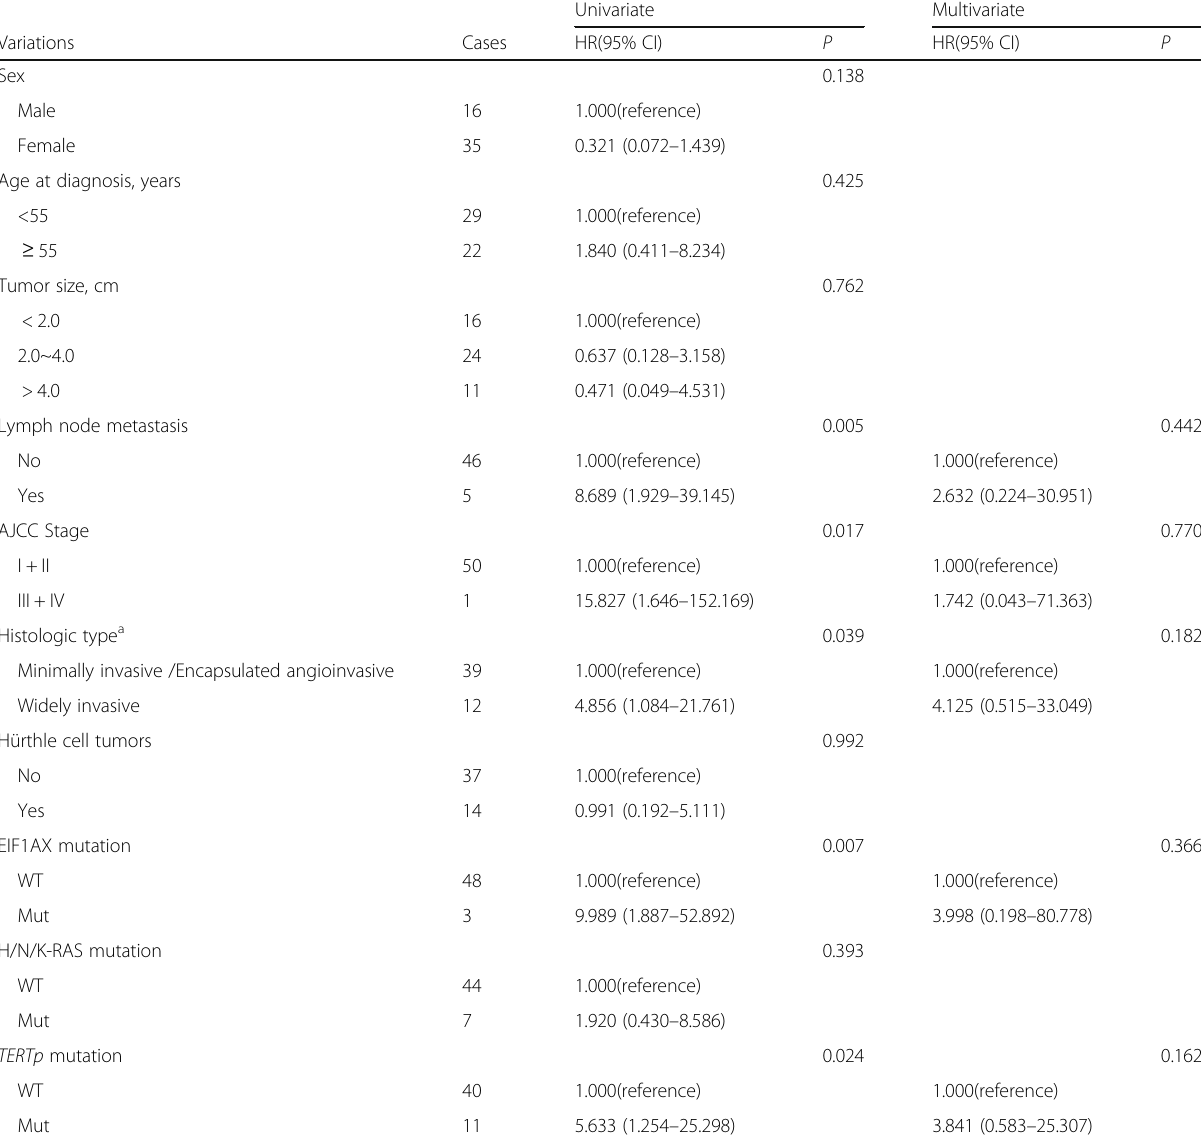
Table 4 Association of clinicopathological and genetic characteristics with disease- free survival in 51 FTC Univariate